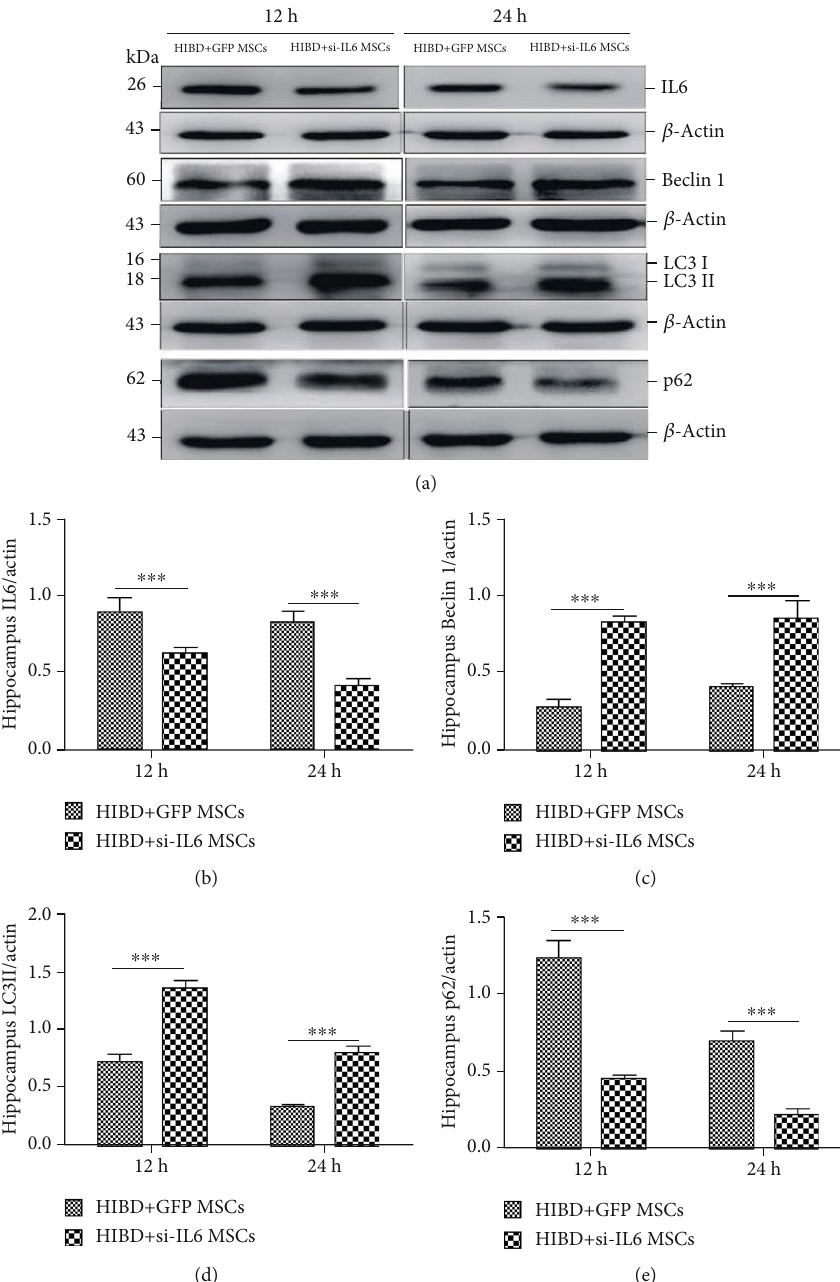
Figure 5: siIL-6 MSC transplantation impaired the e ff ects of MSCs on Beclin 1, LC3 II, and p62 protein expression levels at 12 and 24h after HIBD injury. (a) Representative western blots of hippocampal IL-6, Beclin 1, LC3 II, and p62 in HIBD rats following siIL-6 MSCs or GFP MSC transplantation for 12 h and 24h. (b – e) Quanti fi cation analysis of hippocampal protein expression levels normalized to β -actin ( n = 7 , ∗∗∗ P < 0 : 001